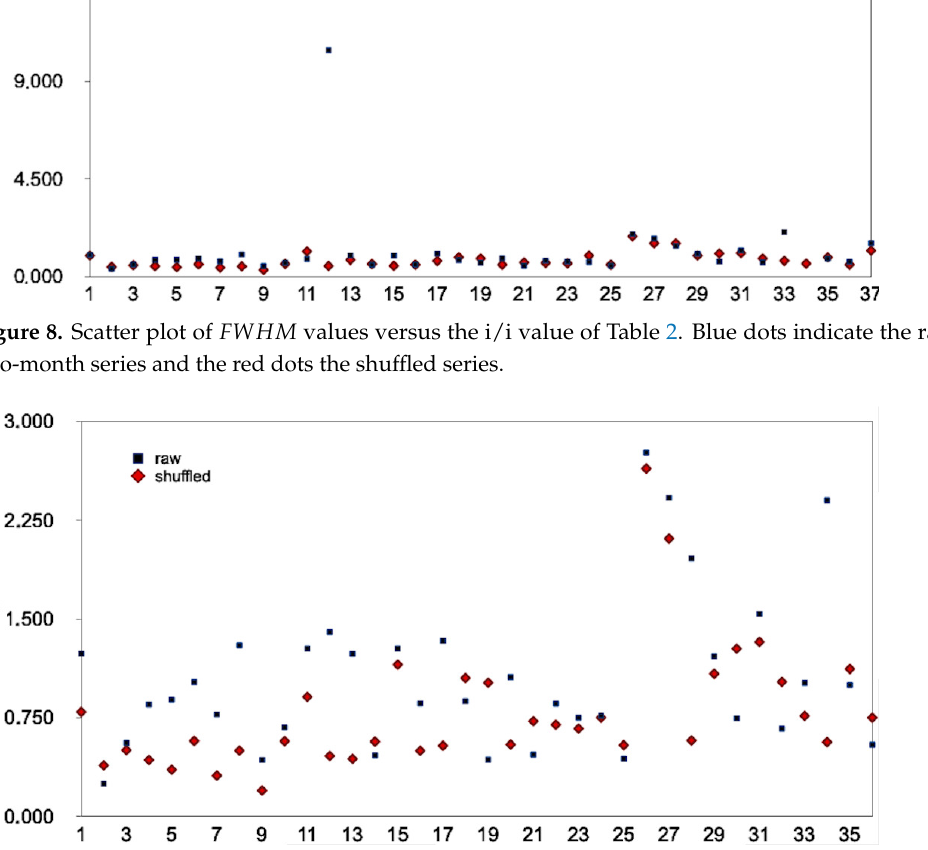
Figure 9. Scatter plot of ranges W (Equation (11)) versus the i/i value of Table 2. Blue dots indicate the raw two-month series and the red dots the shuffled